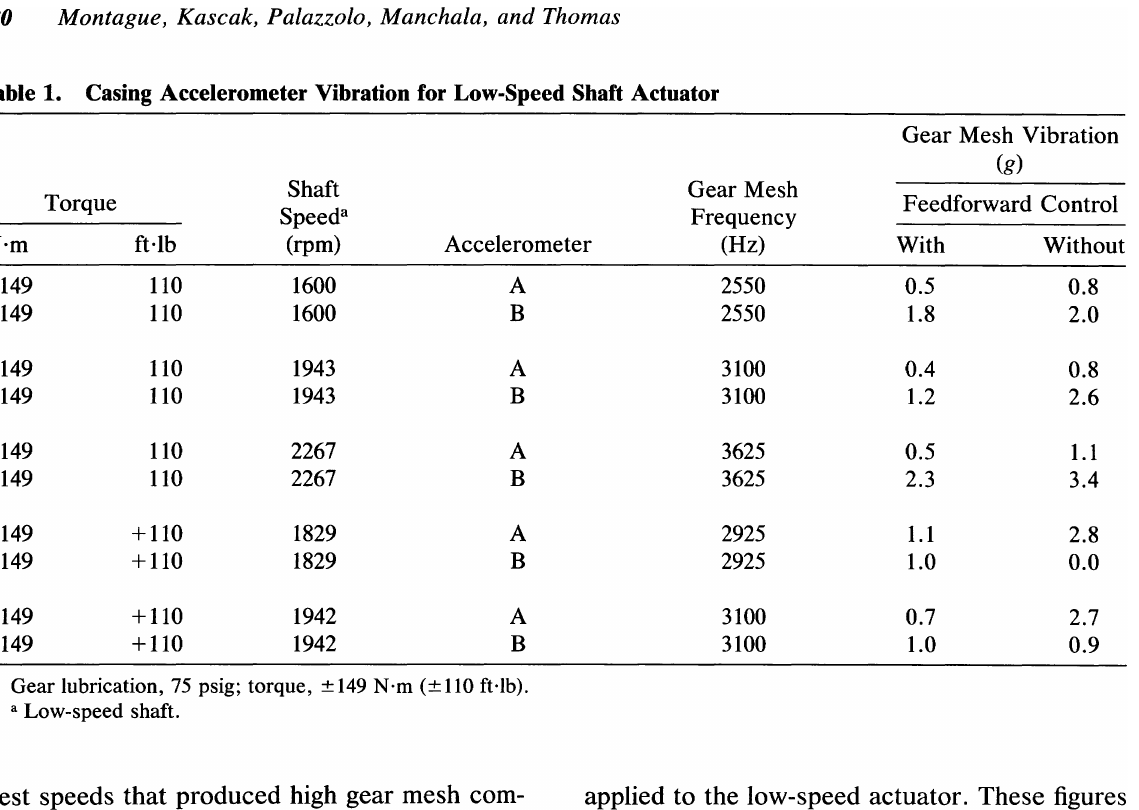
Shaft Gear Mesh Speed a